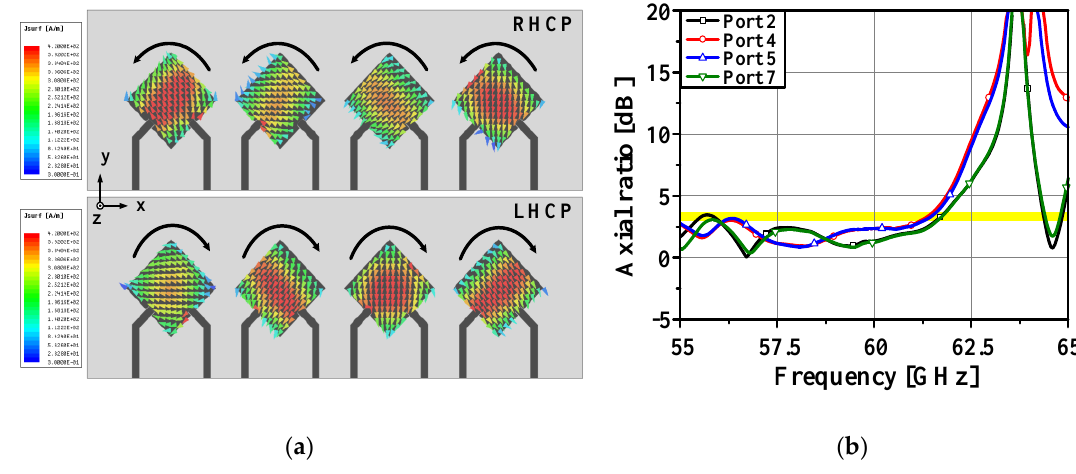
Figure 13. Simulated current distributions and the axial ratio: ( a ) surface current distributions of the patch antenna array and ( b ) axial ratio of the proposed antenna array system.